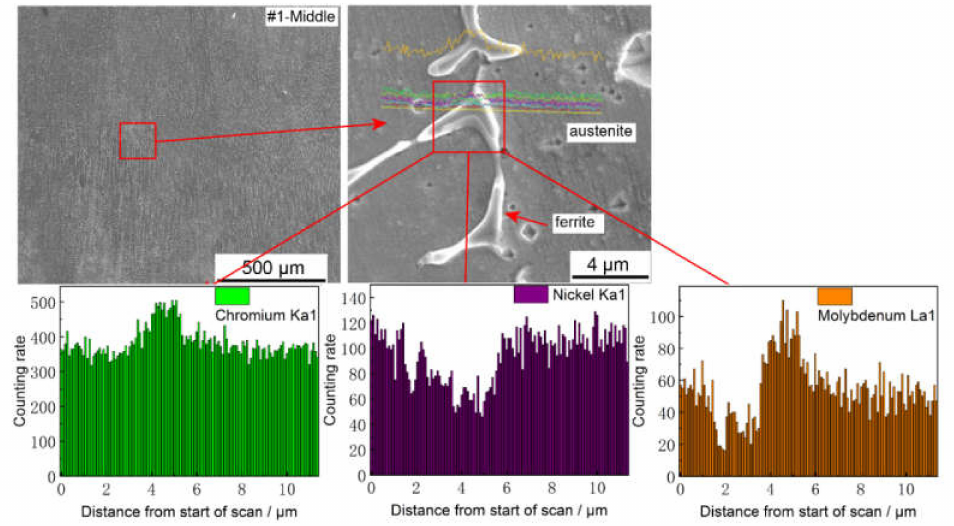
Figure 8. Microscopic morphology and energy spectrum analysis of the middle region of sample